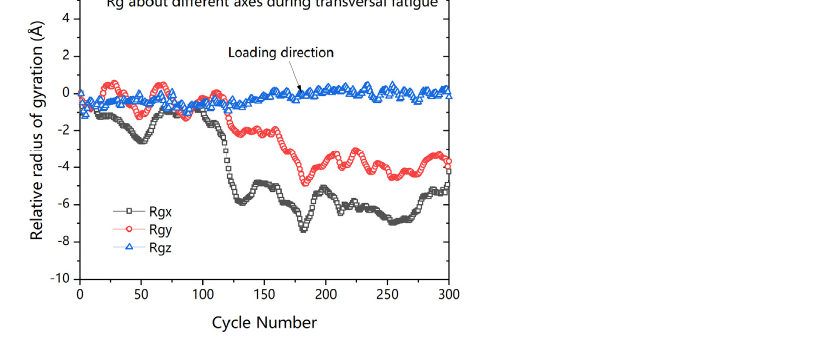
Figure 11. Evolution of the relative radius of gyration during fatigue cyclic loading.